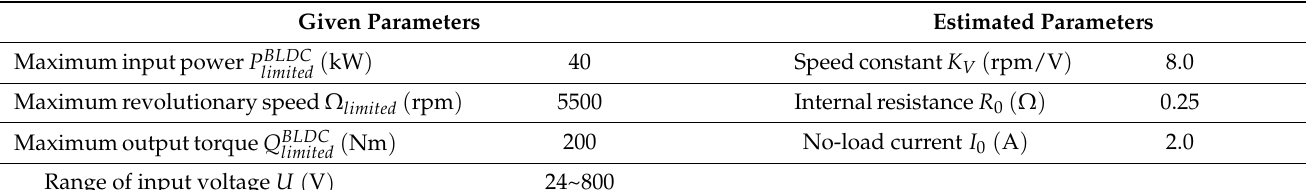
Table 2. Parameters of BLDC motors used in Vahana A 3 .